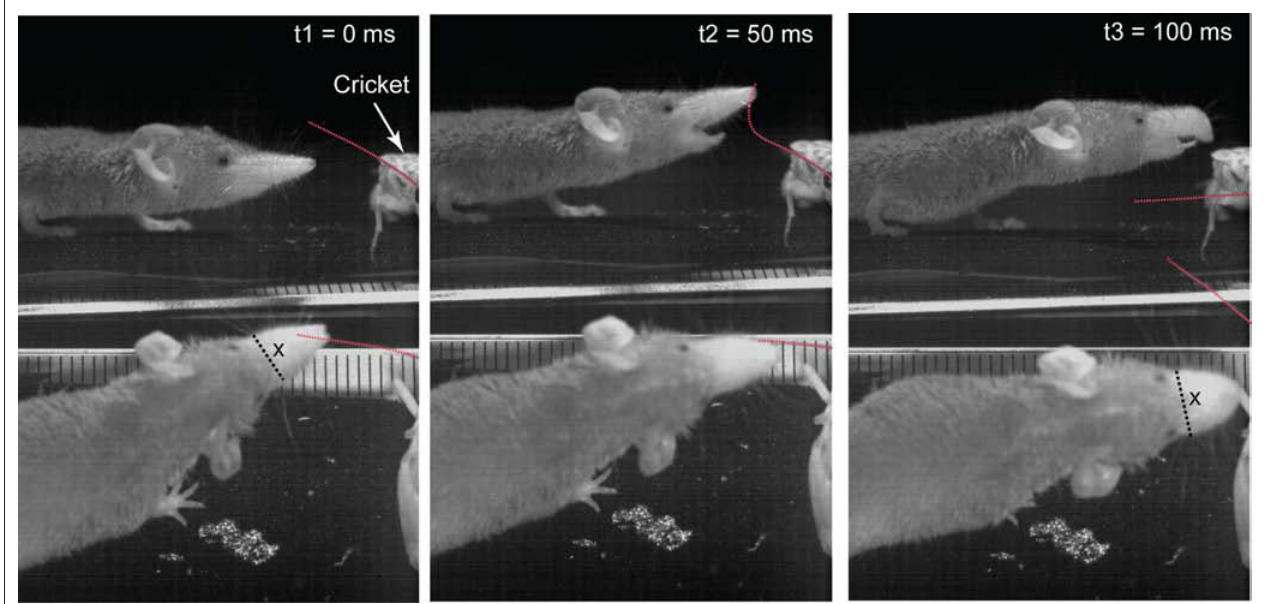
view). This appears to be used to draw the antenna further into the shrew’s mouth. During attack the shrew’s snout becomes wider and rounder, increasing in width, x , from x = 5.6 mm at t = 0, to x = 6.5 mm at 1 t = 100 ms. The cricket’s antenna is outlined in red. Scale tick mark 3 spacing is 1